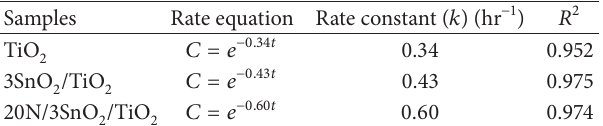
Table 2: A summary of numerical fits of first-order kinetics to the degradation of MB.